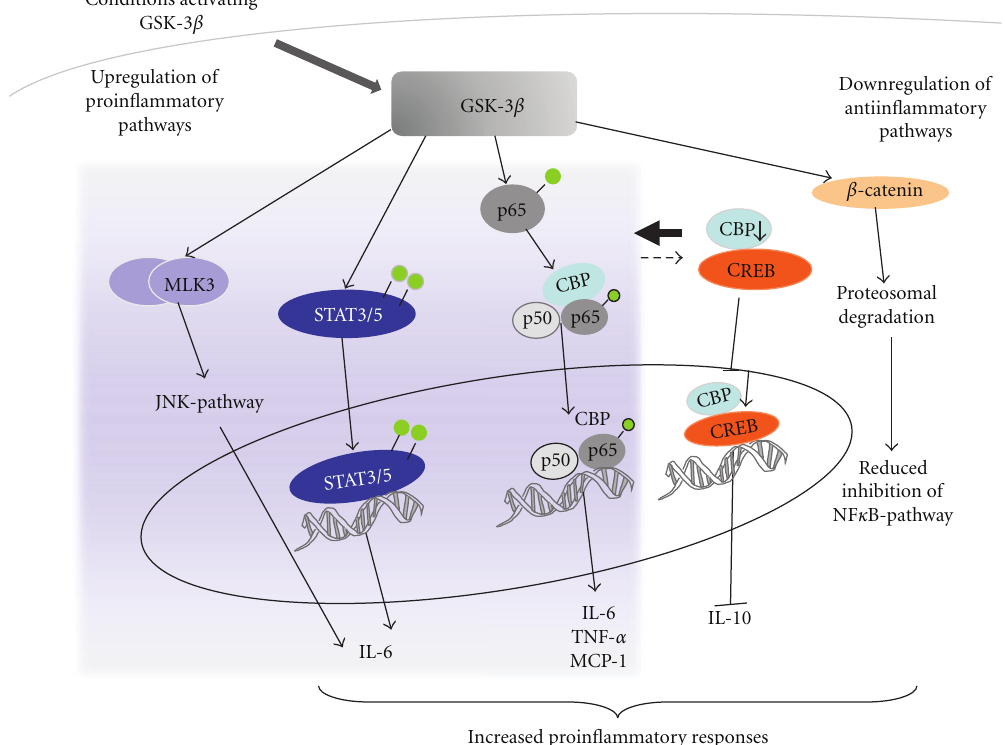
Figure 1: GSK-3 β regulates the production of microglial inflammatory molecules. GSK-3 β activation has been shown to increase the production of proinflammatory mediators via multiple mechanisms. GSK-3 β is able to activate JNK-, STAT3/5- and NF- κ B pathways leading to increased cytokine and chemokine production. GSK-3 β is able to increase the binding of coactivator CREB-binding protein (CBP) to p65 thus enhancing NF- κ B mediated transcription. Since CREB competes for CBP binding, activation of GSK-3 β shifts the balance in favor of NF- κ B pathway and CREB-mediated induction of IL-10 is reduced. Moreover, GSK-3 β activation leads to proteosomal degradation of beta-catenin, thus resulting in reduced inhibition of NF- κ B-activation. All these events lead to enhanced production of proinflammatory